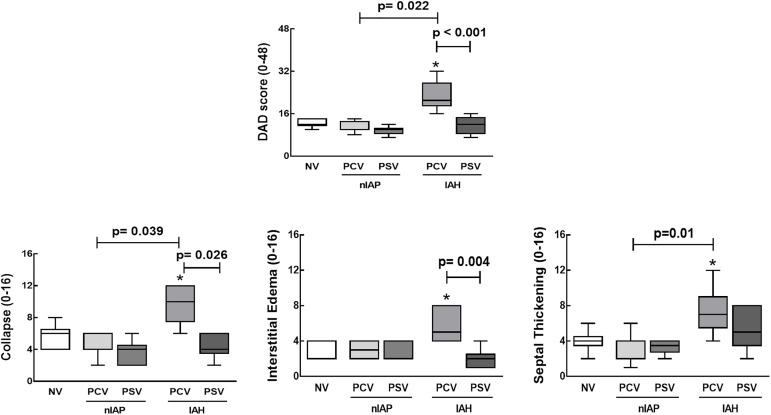
Cumulative DAD score (scores arithmetically averaged from two independent investigators) representing injury from alveolar collapse, interstitial edema, and septal thickening in animals with normal intra-abdominal pressure (nIAP) or intra-abdominal hypertension (IAH) mechanically ventilated in pressure-controlled ventilation (PCV) or pressure support ventilation (PSV) mode.NV: non-ventilated animals. Values are given as medians, interquartile ranges, and minimum/maximum of 6 animals in each group. Statistical significance was accepted at p < 0.05. *Significantly different from NV.